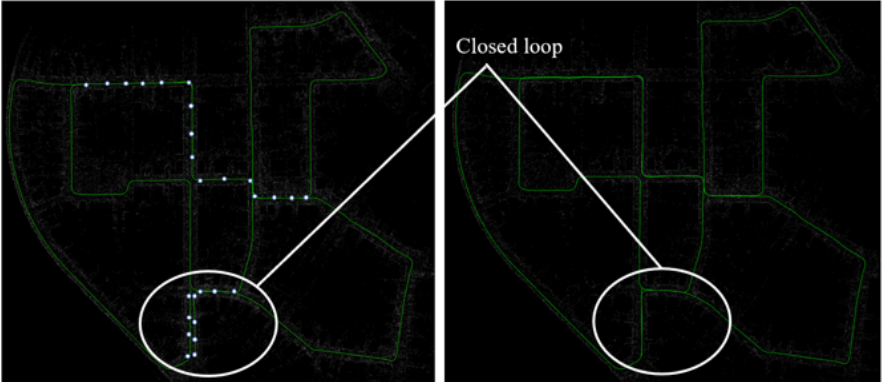
Figure 11. Online loop-closure performance of STV-SC on KITTI 00. Left figure shows the trajectory without loop closure detection and pose graph optimization. The trajectory in the white circle exhibits noticeable drifts. Right figure shows the trajectory after pose graph